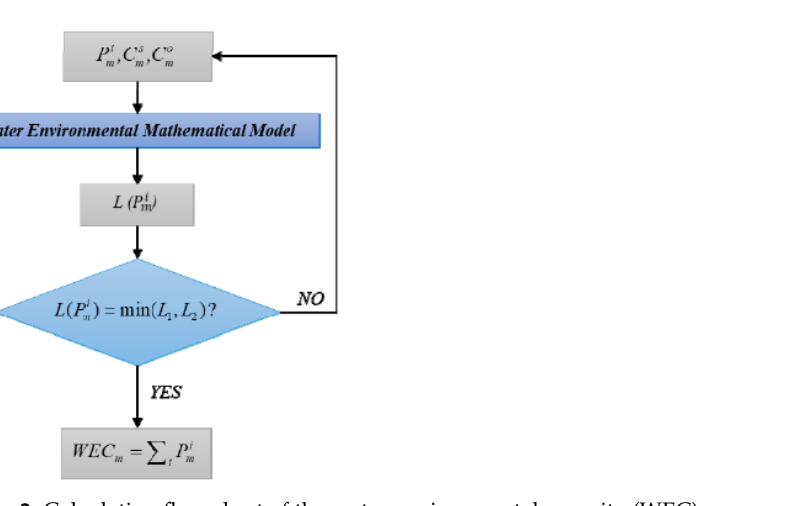
Figure 2. Calculation flow chart of the water environmental capacity (WEC).